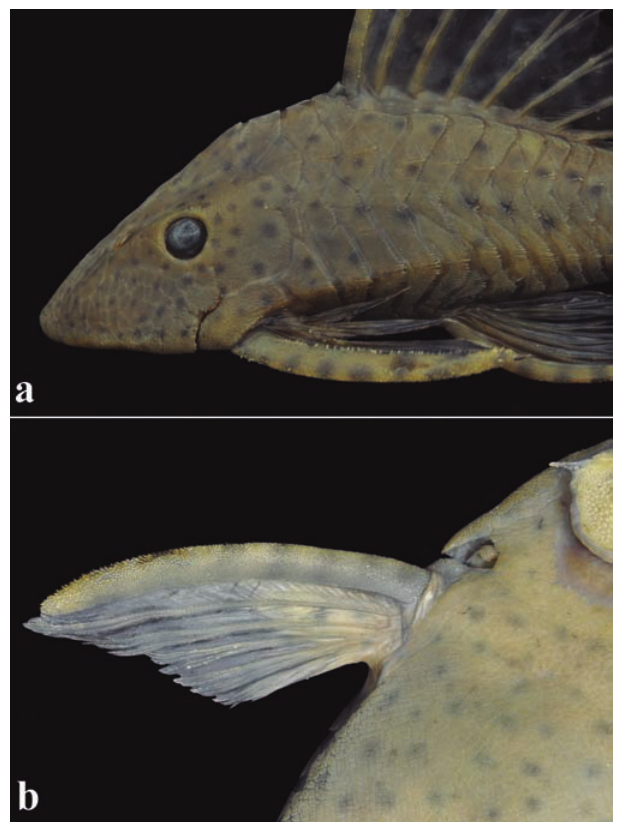
Fig. 7. Spots and color pattern of fins in Hypostomus cochliodon ; (a) NUP 12071, 151.1 mm SL, showing spots smaller and closely spaced on head and larger and widely spaced on the body; (b) NUP 12768, 241.1 mm SL, the base of fin with same color of body, becoming dark brown in tip; and uniform spot pattern in ventral portion of